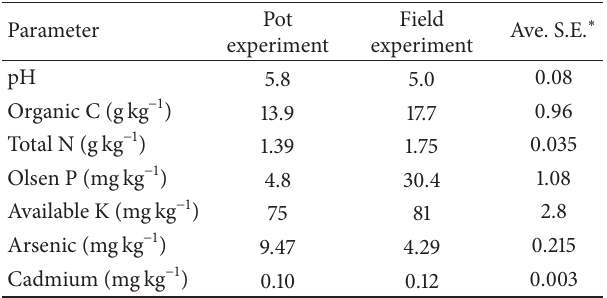
Table 1: Physico-chemical properties of soils used for the pot and field